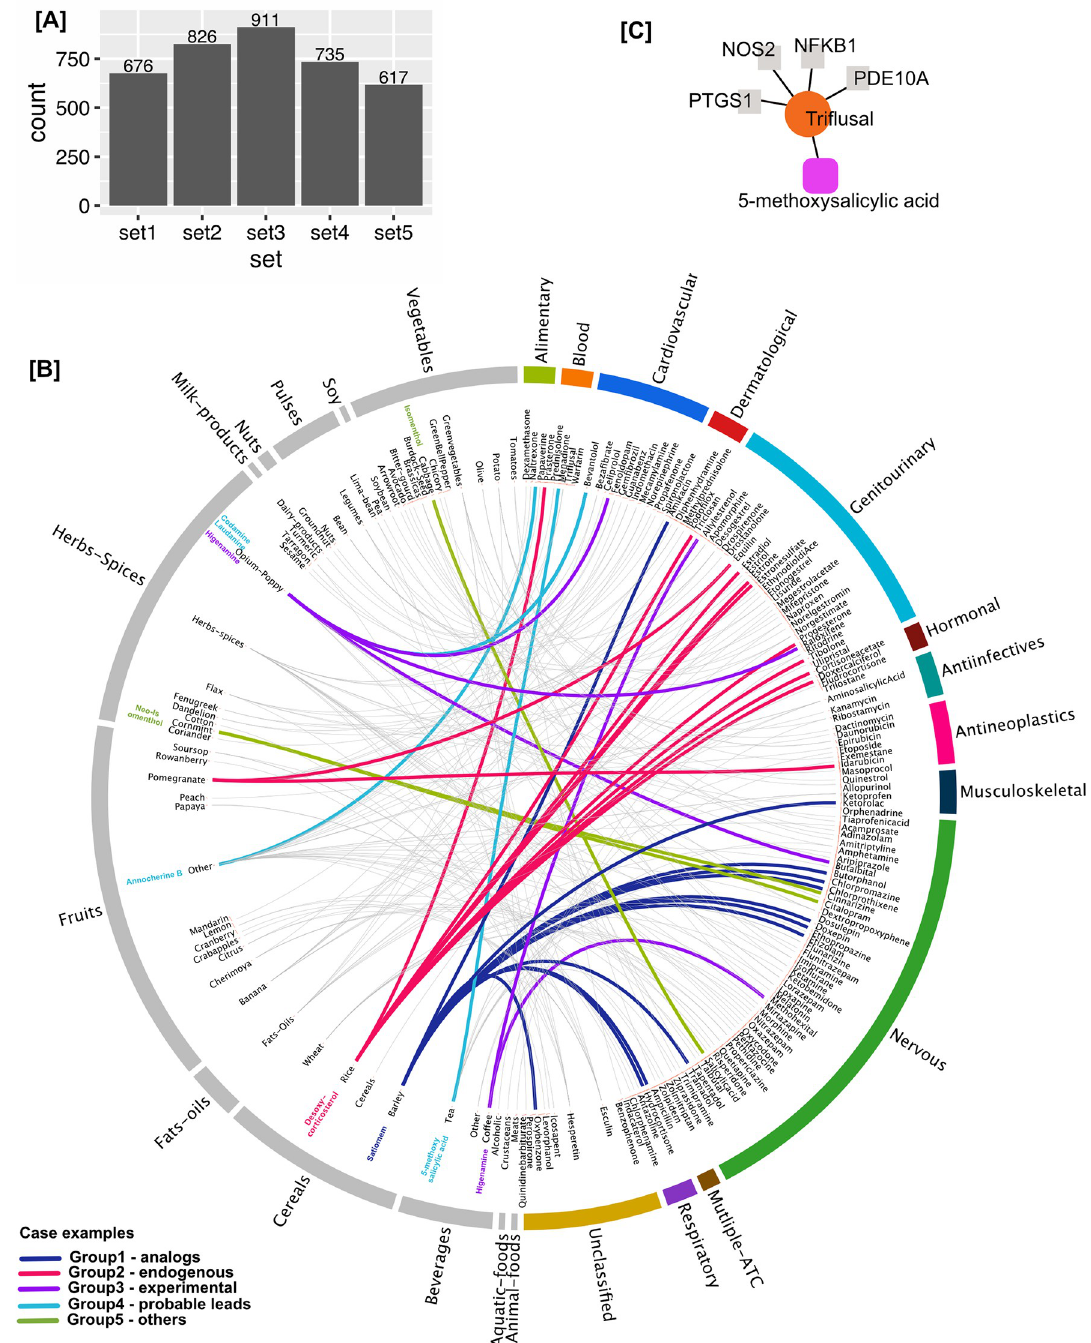
Fig 2. Drug-food compound similarity. (A) Number of hits retrieved from each split-sets model. (B) 200 drug-food pairs predicted as ‘match’ at the probability threshold of > 0.5. The drugs are arranged according to their therapeutic class and food compounds according to their food source. The highlighted colored links represent the case examples in the five author defined groups (details in the text). (C) Group4-probable lead example taken up for experimental validation. The food compound 5-methoxysalicylic acid was a hit with the drug triflusal which has 4 known targets. We validated the inhibitory activity of triflusal and 5-methoxysalicylic acid against the target PTGS1 (also known as Cox-1).